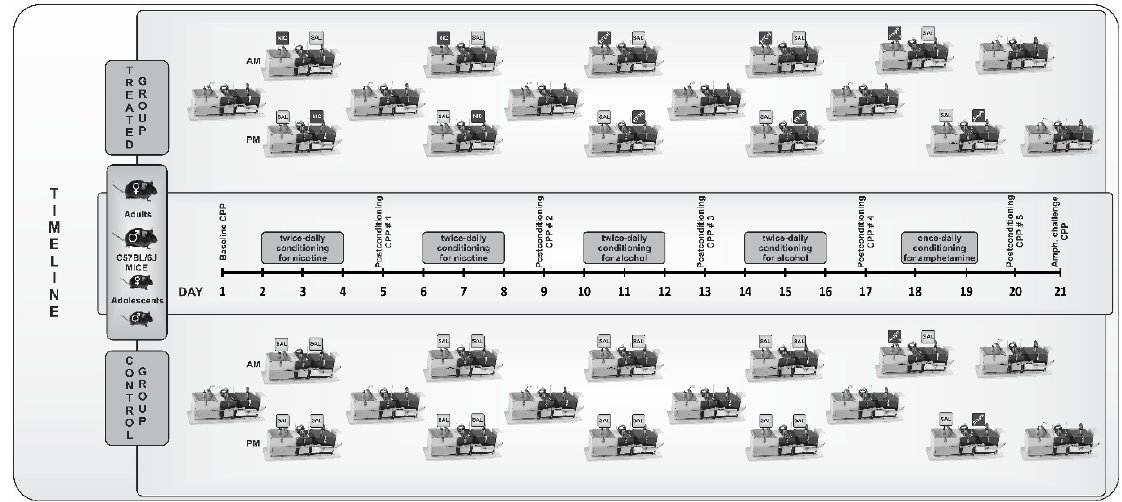
Figure 1. Schematic diagram of the place conditioning paradigm used in the current study.